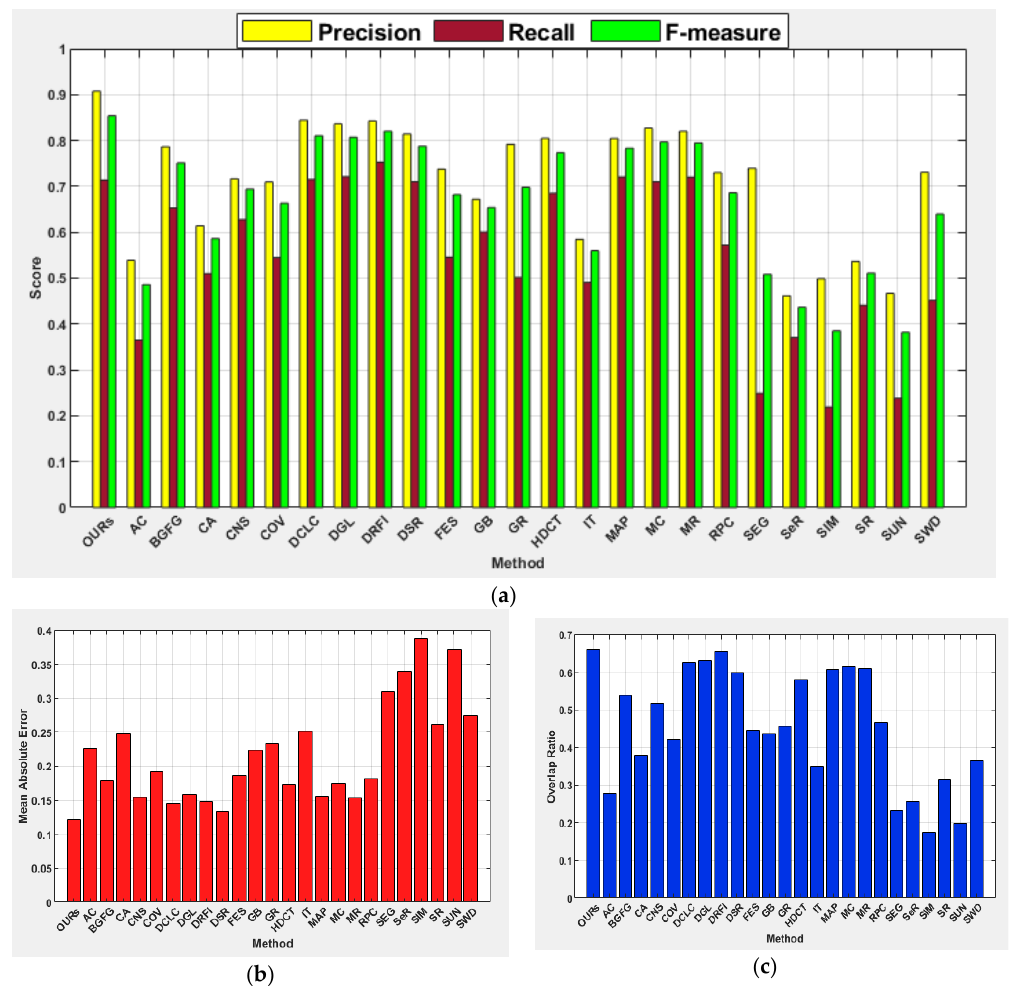
Figure 8. ( a ) F-measure; ( b ) MAE and ( c ) OR on image category: Low contrast.